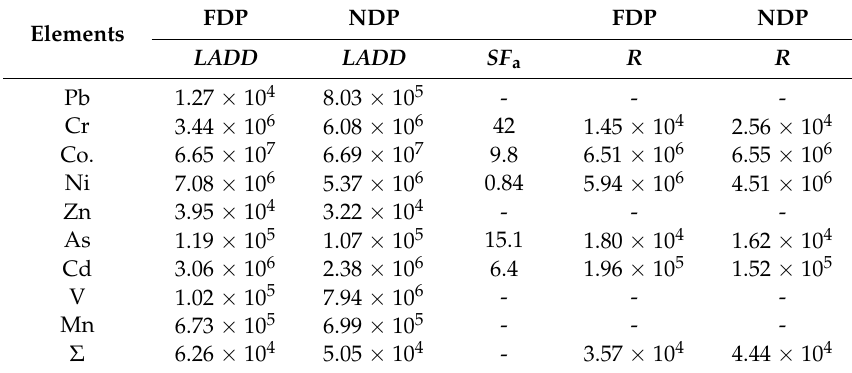
Table 4. Life time average daily doses, slope factors, and cancer risk of given elements for selected metals present in PM 10 in